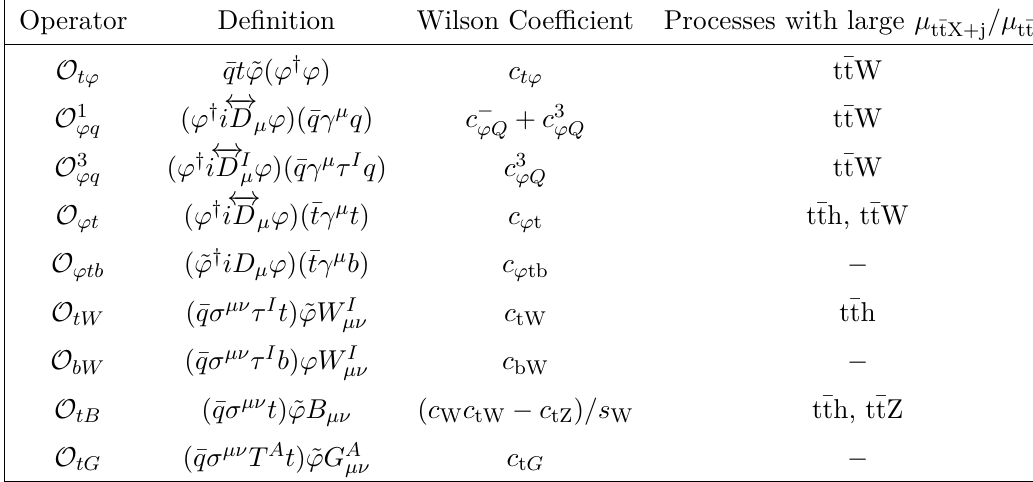
Table 2 . List of operators and corresponding Wilson coefficients considered in this paper indicating for which of the processes we observe a large µ / µ ratio as described in the text. For operators t¯tX+j t¯tX that are associated with two coefficients, if the dependence on either of the coefficients is significantly impacted by the inclusion of an additional parton, the process is